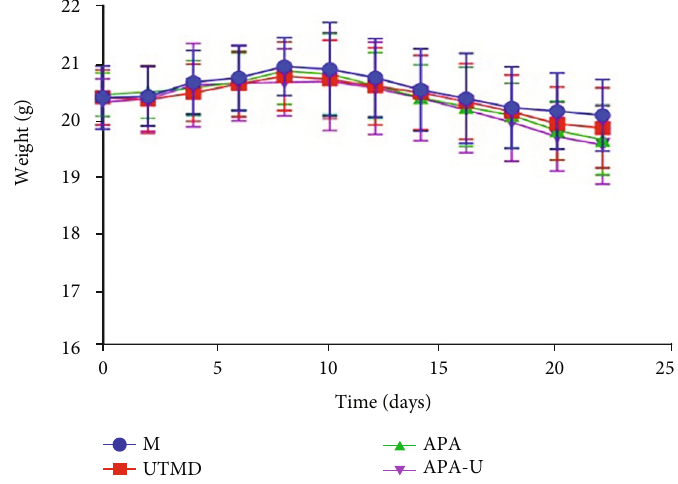
Figure 1: The body weight curve of nude mice in di ff erent